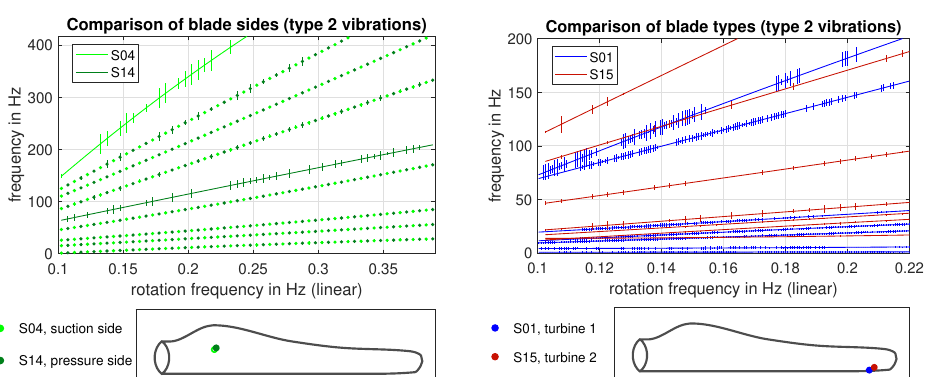
Figure 15. ( Left ) Fingerprint comparison for sensors on pressure side ( S 14) and suction side ( S 04) on the same blade and radial position (Blade A , Test Turbine 2). ( Right ) Comparison for tip sensors on Test Turbine 1 ( S 01) and Test Turbine 2 ( S 15). Solid lines represent vibrations of a single sensor, dotted multi-coloured lines represent jointly occurring vibrations. Error bars show locations of associated peaks with their length representing peak